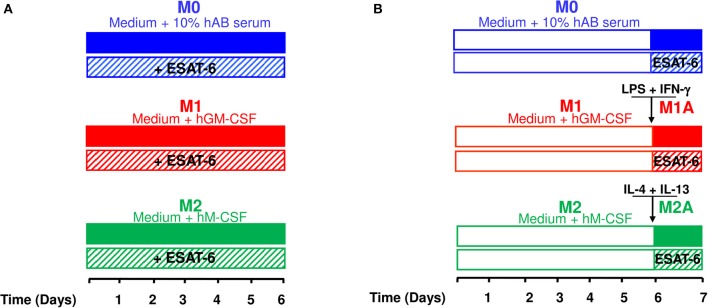
Experimental procedures used to generate different macrophage subpopulations. The experimental procedures carried out to assess effects of ESAT-6 on MΦ differentiation, polarization and activation were based on the recommended protocol guidelines (Murray et al., 2014). (A) Human-derived monocytes, from three different donors, were incubated in medium containing human AB serum for 6 days to obtain non-polarized M0 MΦs. M1 and M2 MΦs were obtained by adding 100 ng/mL GM-CSF and 10 ng/mL M-CSF, respectively. Effects of ESAT-6 on MΦ differentiation were assessed by adding 10μg/mL of the recombinant protein. (B) To generate fully activated (M1A and M2A) MΦs, cells were treated as in A for 6 days before adding for 24 h the activation cocktail (10 ng/mL LPS and 20 ng/mL IFN-γ for M1A MΦs; 20 ng/mL IL-4 and 20 ng/mL IL-13 for M2A MΦs). Effects of ESAT-6 on fully activated MΦs were evaluated by adding 10 μg/mL of the recombinant protein to the activation cocktail at day 6.